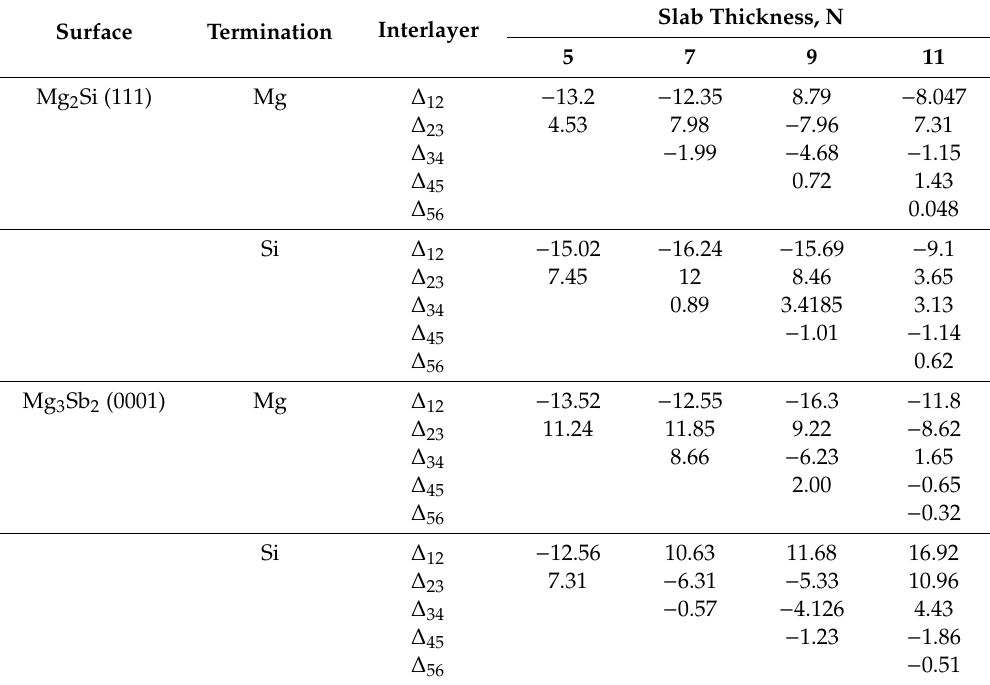
Table 2. The interlayer relaxation change ( ∆ ij ) convergence of Mg 2 Si (111) and Mg 3 Sb 2 (0001) with respect to the termination and atom